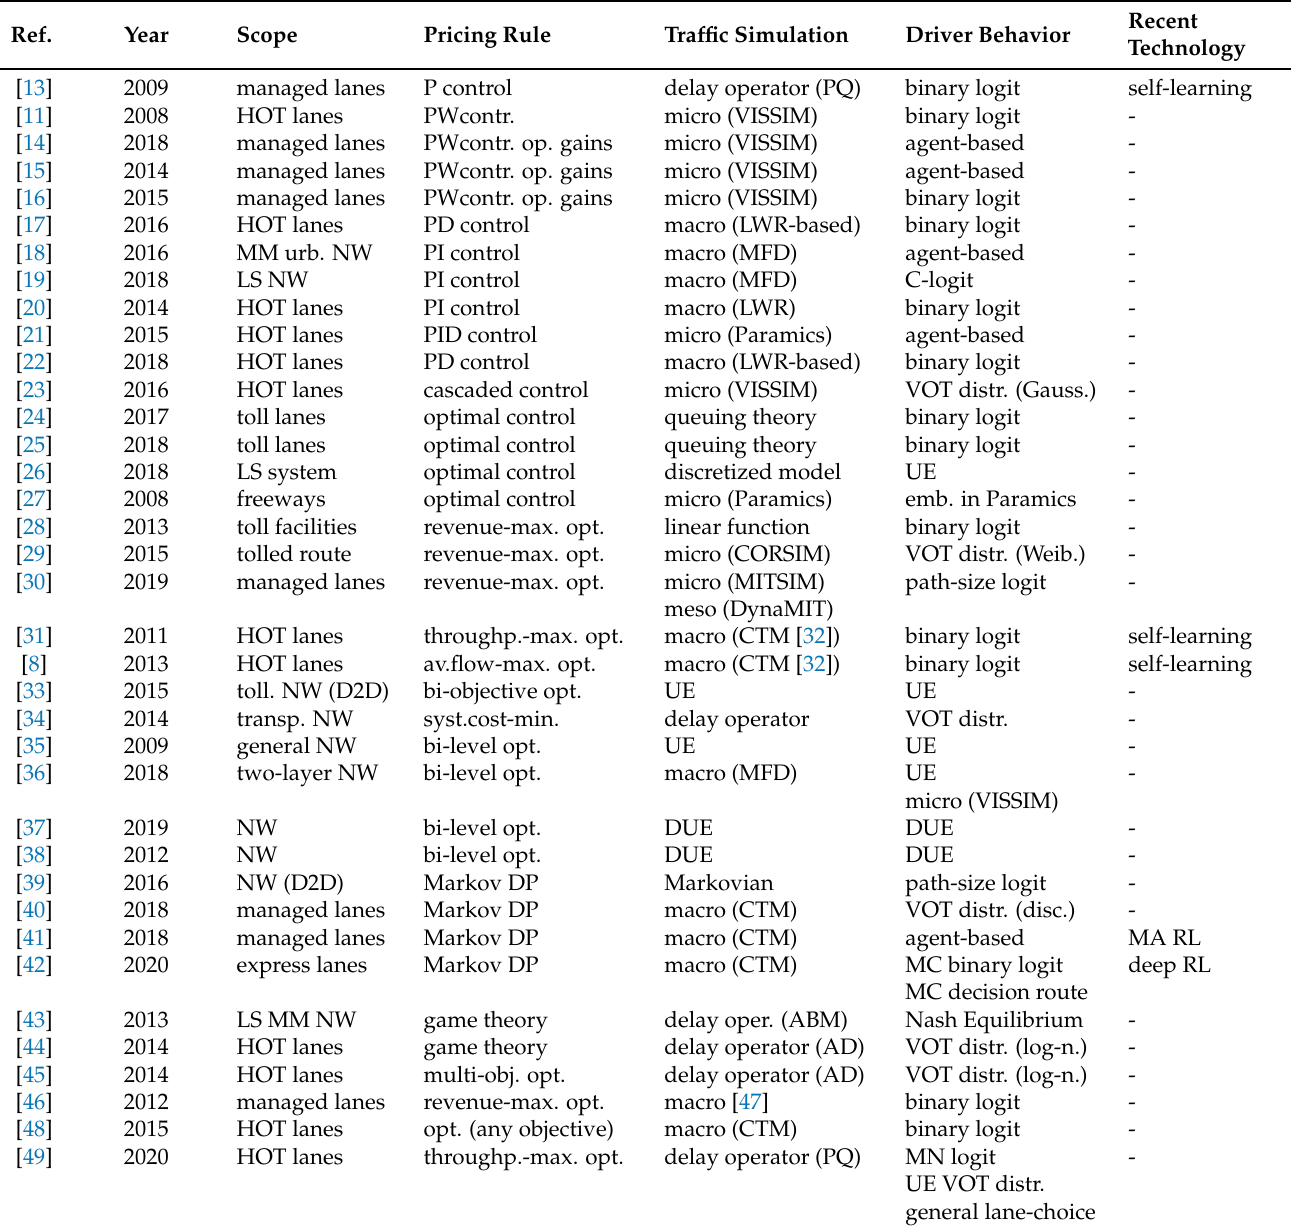
Table 3. A list of the main reviewed studies described by reference (Ref.), year of publication, scope, main pricing rule principle, traffic simulation basis, driver behavior model and recent technology application. We included in the table also some studies which do not give a complete pricing scheme, but are limited to the presentation of some tool which can be combined with other models in order to obtain a complete pricing scheme. The following abbreviations are adopted in this table: AD = Arrivals-Departures, adj. = adjustable, av. = average, bottl. = bottleneck, CTM = Cell Transmission Model, D2D = Day-to-day, discr. = discrete, distr. = distribution, DTC = de- parture time choice, DUE = Dynamic User Equilibrium, emb. = embedded, enh. = enhanced, fac. = facilities, Gauss. = Gaussian, infl. = inflow, log-n. = log-normal, LS = large scale, LWR = Lighthill-Witham-Richards, macro = macroscopic, max. =